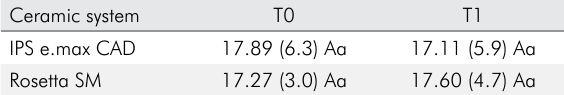
Table 3. Mean microshear bond strength (MPa) values (SD) of a self-adhesive resin cement to CAD-CAM lithium disilicate glass ceramic systems immediately (T0) and after 30 days